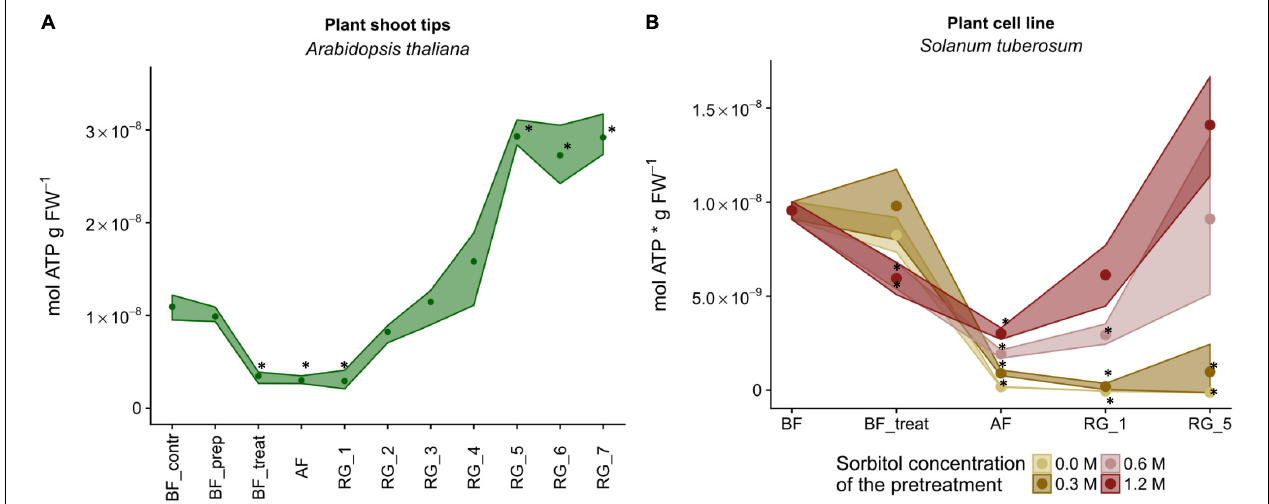
FIGURE 5 | Strain-specific responses in intracellular ATP concentrations during cryostress experiments of plant shoot tips and a plant cell line. ATP content of cells from the individual strains before freezing (BF), after the addition of a cryoprotectant (BF_treat), after freezing and thawing (AF) and after a regrowth phase (RG). Depicted are the means of the biological replicates with 95% confidence intervals represented as ribbons. (A) Response of Arabidopsis thaliana Col-0 shoot tips. BF_contr, control (wild-type seedlings); BF_prep, prepared (freshly excised shoot tips); RG_1 – RG_7, regrowth after 1–7 days. (B) Response of Solanum tuberosum cv. Desiree suspension cells after pretreatment with different sorbitol concentrations. RG_1 and RG_5, regrowth after 1 and 5 week(s). ∗ denotes values that were significantly different ( p < 0.05) from the BF value of the respective strain. FW, fresh weight.